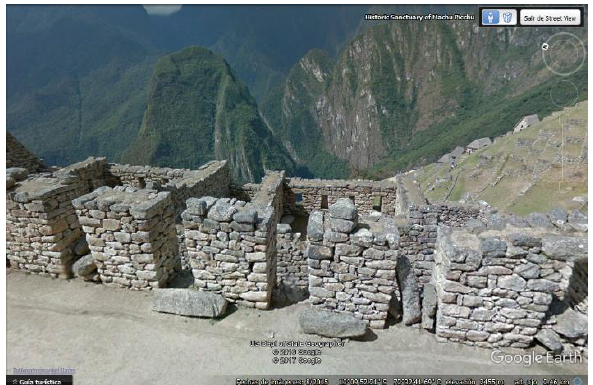
Figure 9. Historic Sanctuary of Machu Picchu. Peru. © US Dept. of State Geographer. GOOGLE. Image: Screen capture, 2017. Google Earth.